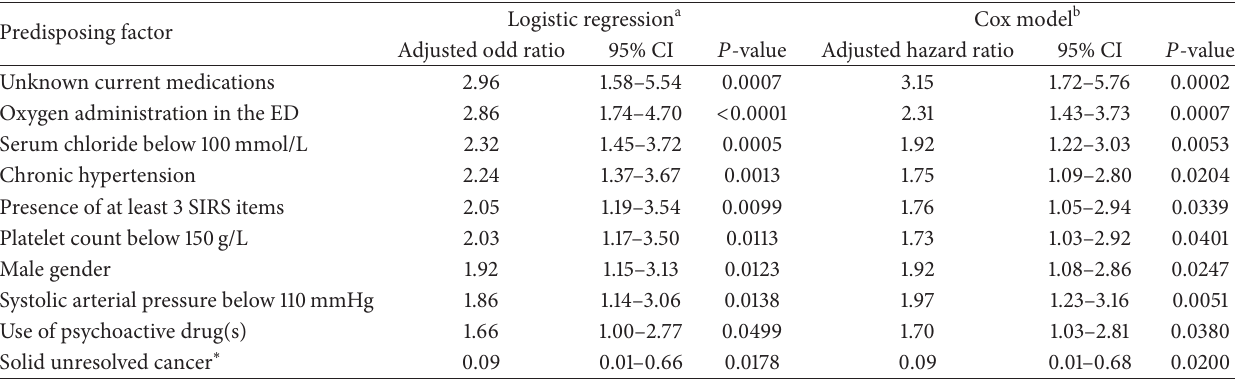
Table 3: Variables identified as potential predisposing factors for 15-day clinical worsening during hospitalization on regular wards, by multivariate logistic regression and by Cox proportional hazards